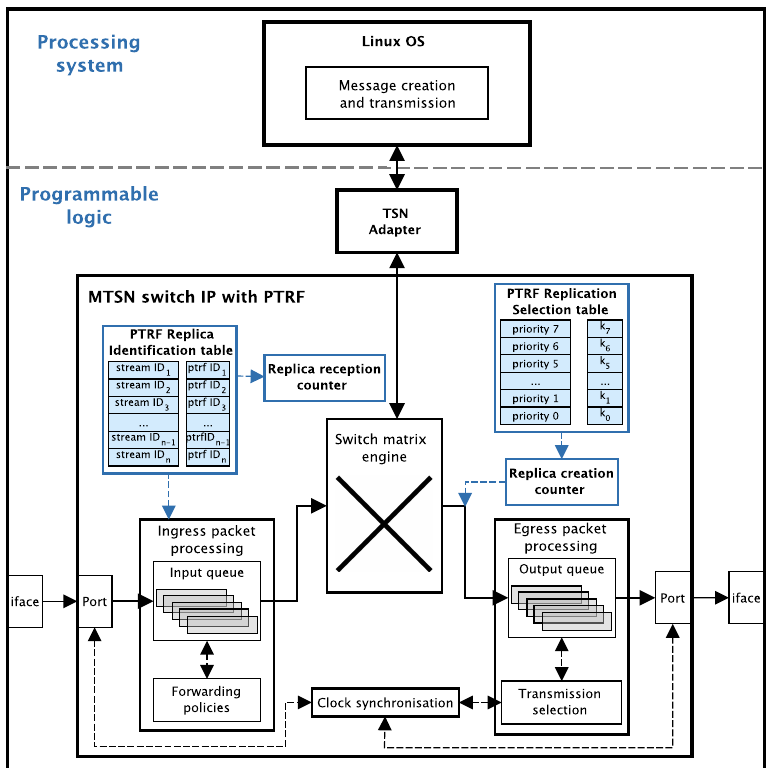
Figure 12. Basic architecture of the MPSoC that implements the PTRF mechanism. The PTRF components are highlighted in blue. Solid lines represent the path which frames follow whereas dashed lines represent management or configuration